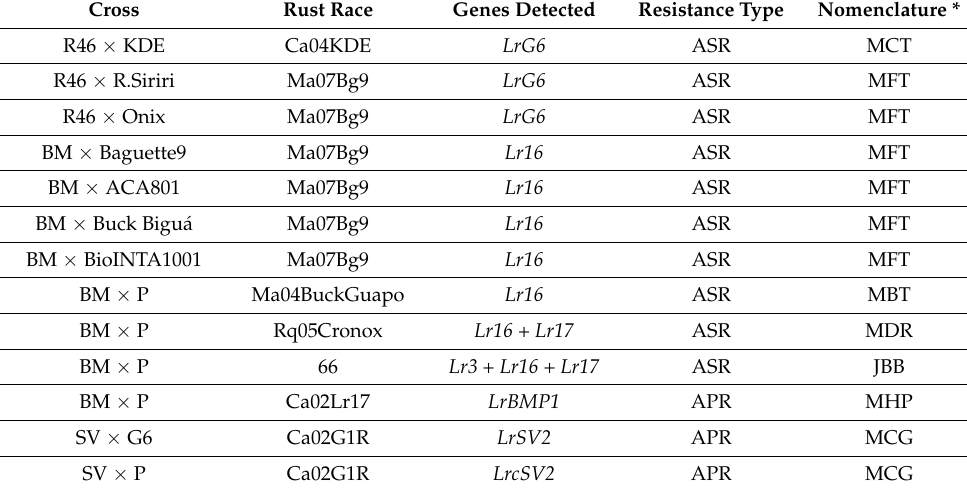
Table 1. Leaf rust traces used in this work. * According to North American System [40]. Cross Rust Race Genes Detected Resistance Type Nomenclature